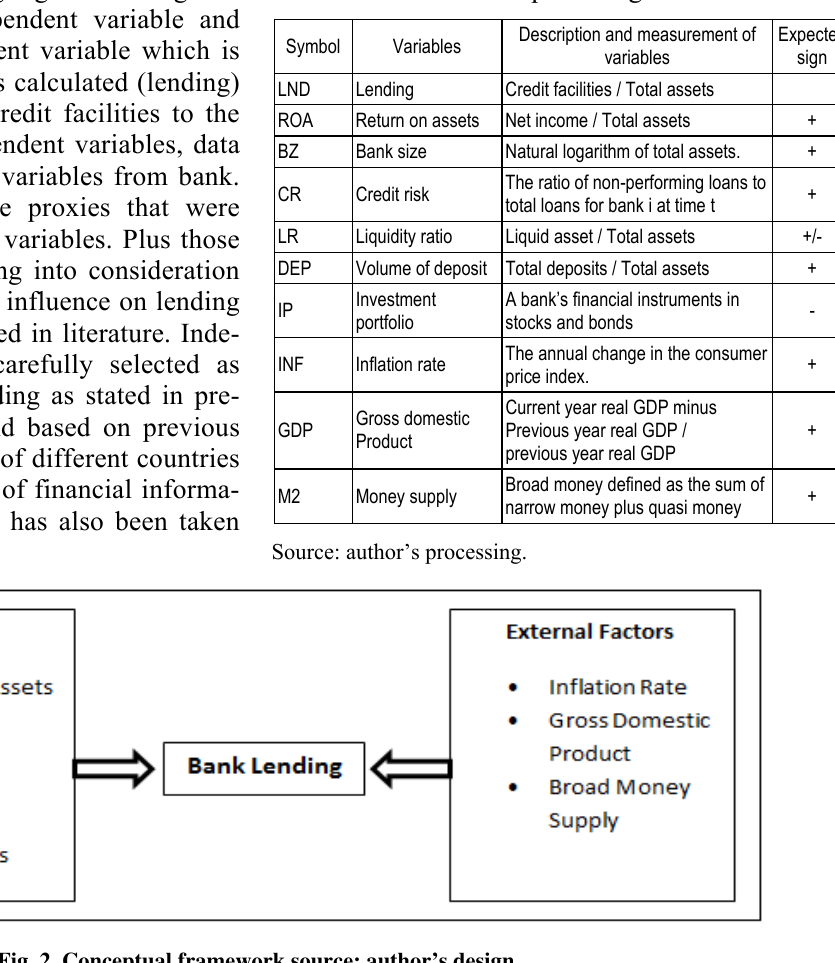
Fig. 2. Conceptual framework source: author’s design